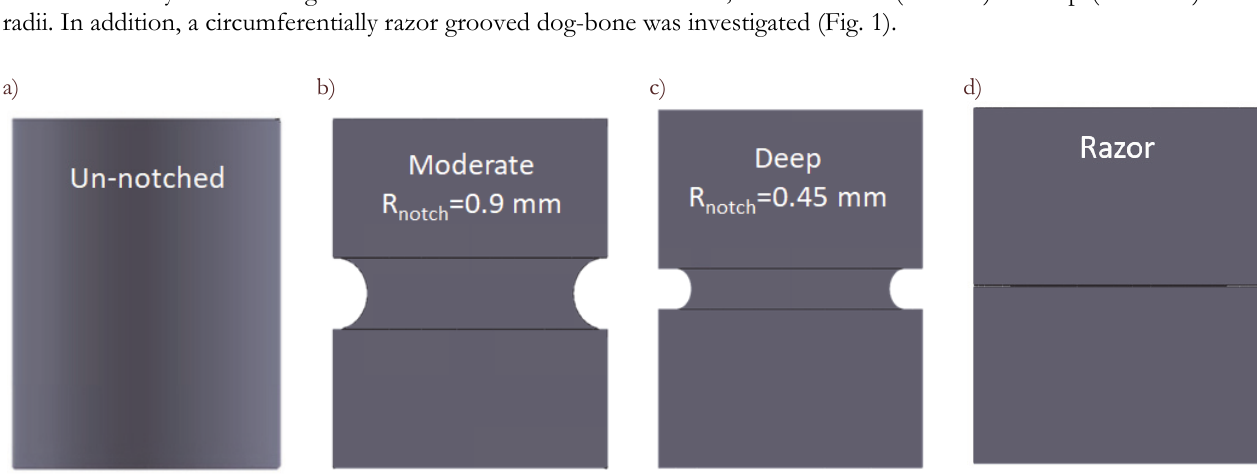
Figure 1: Schematic view of the specimen geometries: a) neat sample; b) U-notched sample with notch radius of 0.9 mm; c) U-notched sample with notch radius of 0.45 mm; d) circumferentially razor grooved